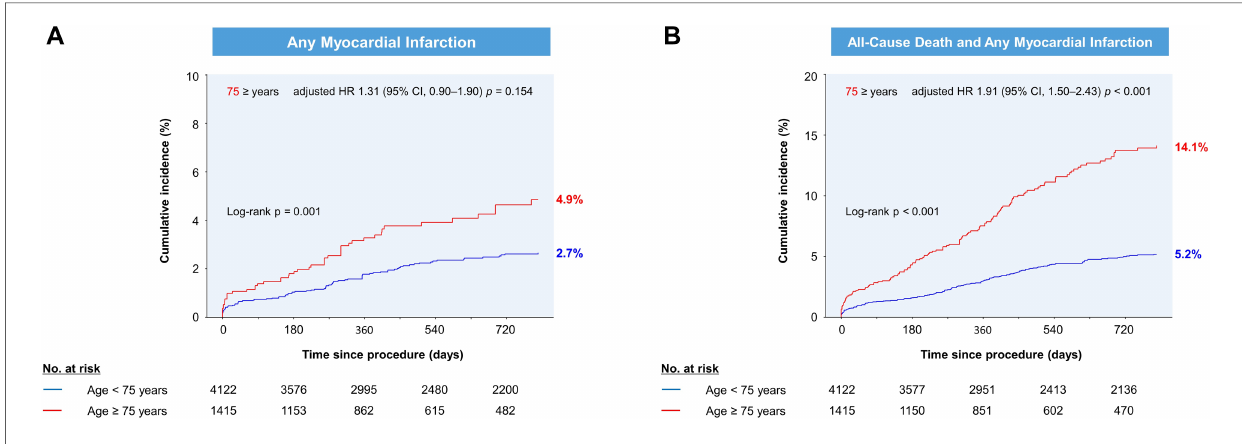
FIGURE 2 Cumulative incidence of ( A ) any myocardial infarction and ( B ) combined all-cause death and any myocardial infarction by age group. The Kaplan-Meier estimates at 720 days are shown. HR, hazard ratio; CI, con fi dence interval.